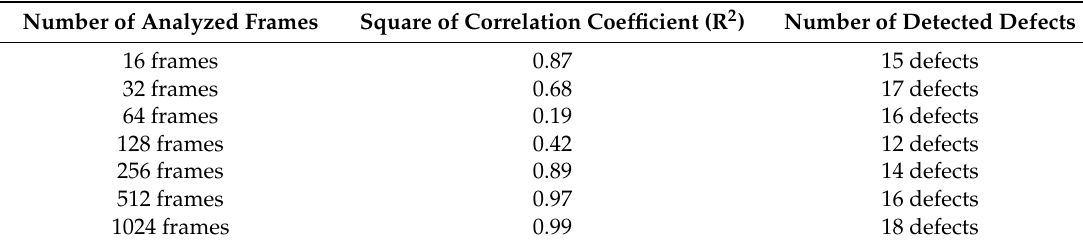
Table 3. Slope algorithm: Evaluation of the SBC-r correlation for different frame intervals. Number of Analyzed Frames